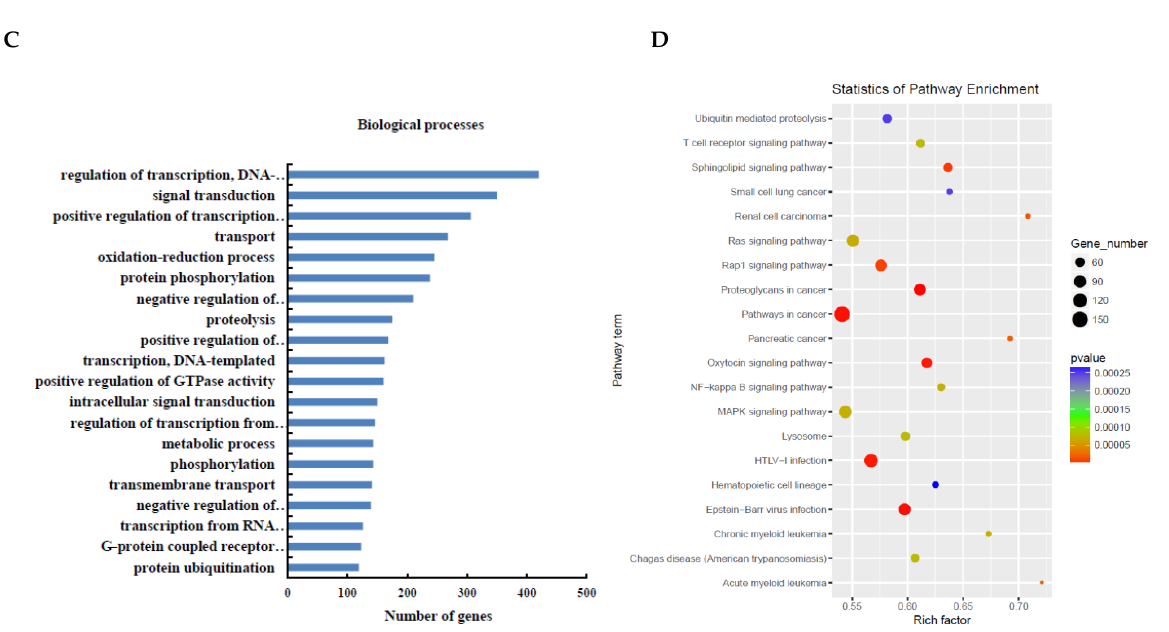
Figure 3. Enrichment analysis of predicted target genes of deregulated miRNAs. ( A ) Significantly altered cellular processes of predicted target genes of DEmiRNAs after H 2 O 2 treatment (100 μM). ( B ) Significantly altered pathways of the target genes. ( C ) Significantly altered cellular processes of predicted target genes of DEmiRNAs after H 2 O 2 treatment (300 μM). ( D ) Significantly altered path- ways of the target genes.